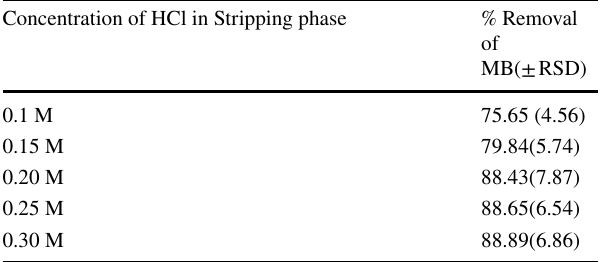
Feed: 100 mg/L MB at pH = 11; PIM: RC8 (0.05 g/g CTA) + 2-NPOE (0.4 mL/g CTA); stripping phase; 0.1 M–0.3 M HCl; Transport time = 30 h. T 25